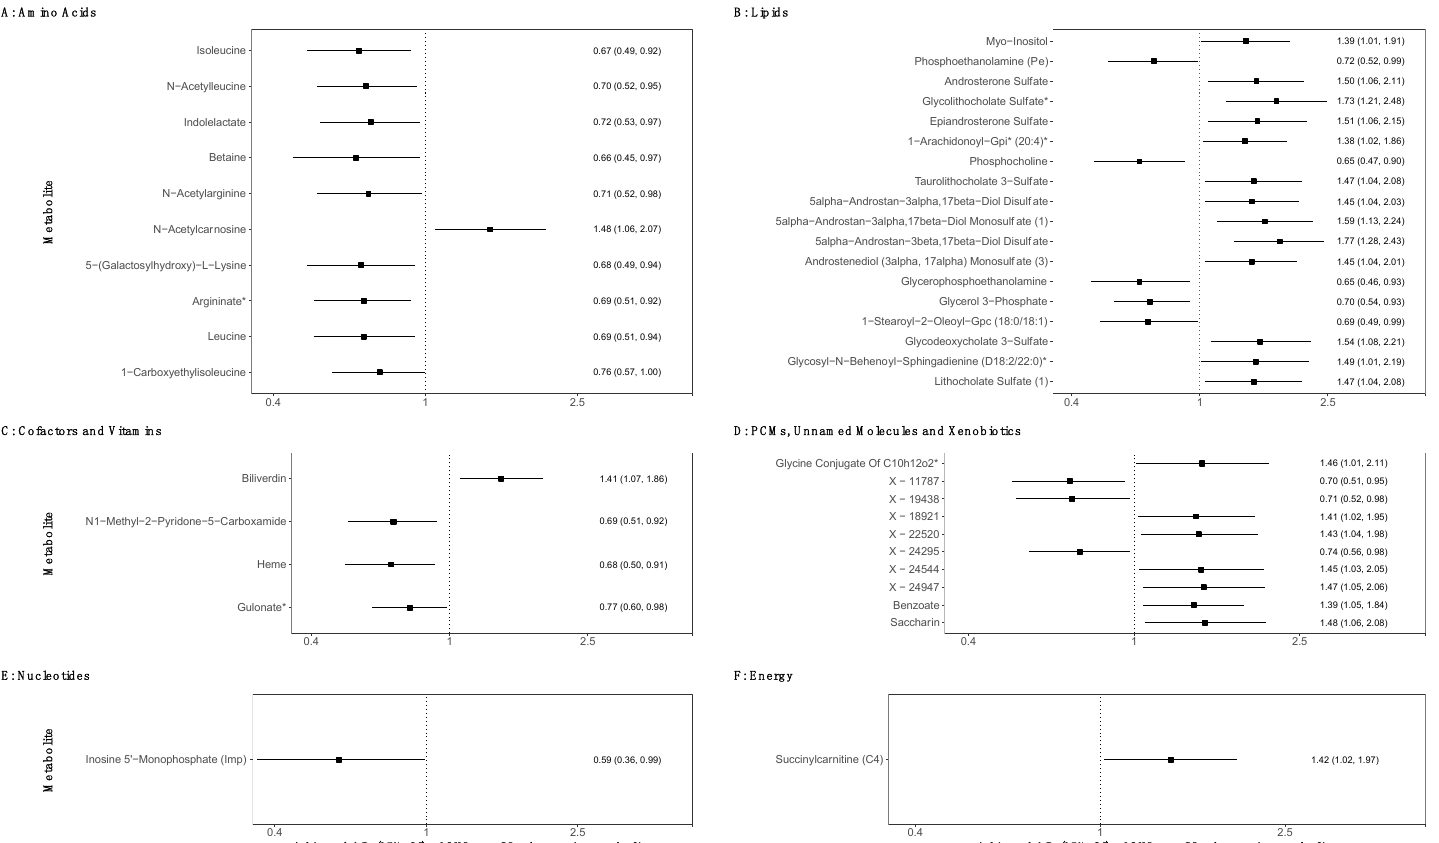
Figure 2. Pooled confounder adjusted associations of maternal pregnancy metabolites with offspring congenital heart disease in the Born in Bradford cohort (N = 2391 and N CHD cases = 42). The associations show confounder adjusted odds ratios of CHD per standard deviation change in log-transformed metabolite levels for the 44 (out of 923) metabolites that associated with CHD at p -value <0.05 separated by super pathways as defined by Metabolon. Metabolites were measured at ~26–28 weeks’ gestation. Heterogeneity statistics and separate associations for datasets 1 and 2 are reported in Supplementary Tables S5–S7. Associations were adjusted for maternal age, ethnicity, parity, Index of Multiple Deprivation, body mass index, smoking and alcohol intake. * at the end of metabolite names as defined by Metabolon. Abbreviations: PCMs, partially characterised molecules; OR, odds ratio; CHD, congenital heart disease; SD, standard deviation. 3.3. Validating Findings with Mendelian Randomization The distributions of offspring and maternal characteristics for the MR analyses in BiB, ALSPAC and MoBa are displayed in Table S3 (Supplementary File 1). It was possible to explore MR replication for 27 of the 44 metabolites that associated with CHD in the mul- tivariable analyses (the other 17 were either not available in the GWAS or had genetic variants not available in the cohorts, Figure S3). All but three of the GRSs (24/27 (89%)) were associated with the corresponding metabolite during pregnancy in BiB (with R 2 val- ues ranging from 0.3% to 34%), but for the remaining three, the associations were impre- cise with wide confidence intervals that included the null (Table S4; Supplementary File 1). Of the 27 GRSs, 3 were specific for the metabolite they were instrumenting (i.e., they had the strongest association with it and little evidence of associations with other metab- olites; N-acetylcarnosine, phosphocholine and succinylcarnitine). Eighteen GRSs were as- sociated with the metabolite they were instrumenting and several others that were corre- lated with that metabolite (e.g., the biliverdin GRS was associated with it and also simi- larly with other hepatic-related metabolites). Six GRSs were more strongly associated with other (uncorrelated) metabolites than the one they were instrumenting (scatter plots for all twenty-seven GRSs are shown in Figure S4; Supplementary File 1). The six non-specific GRS were for indolelactate, glycolithocholate sulfate, isoleucine, leucine, myo-inositol and